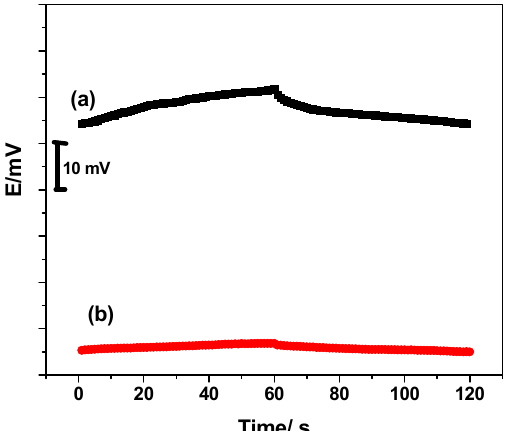
Figure 7. Chronopotentiometry for NaDC / MIP–ISEs with ( a ) and without ( b ) SWCNTs as a solid contact material.